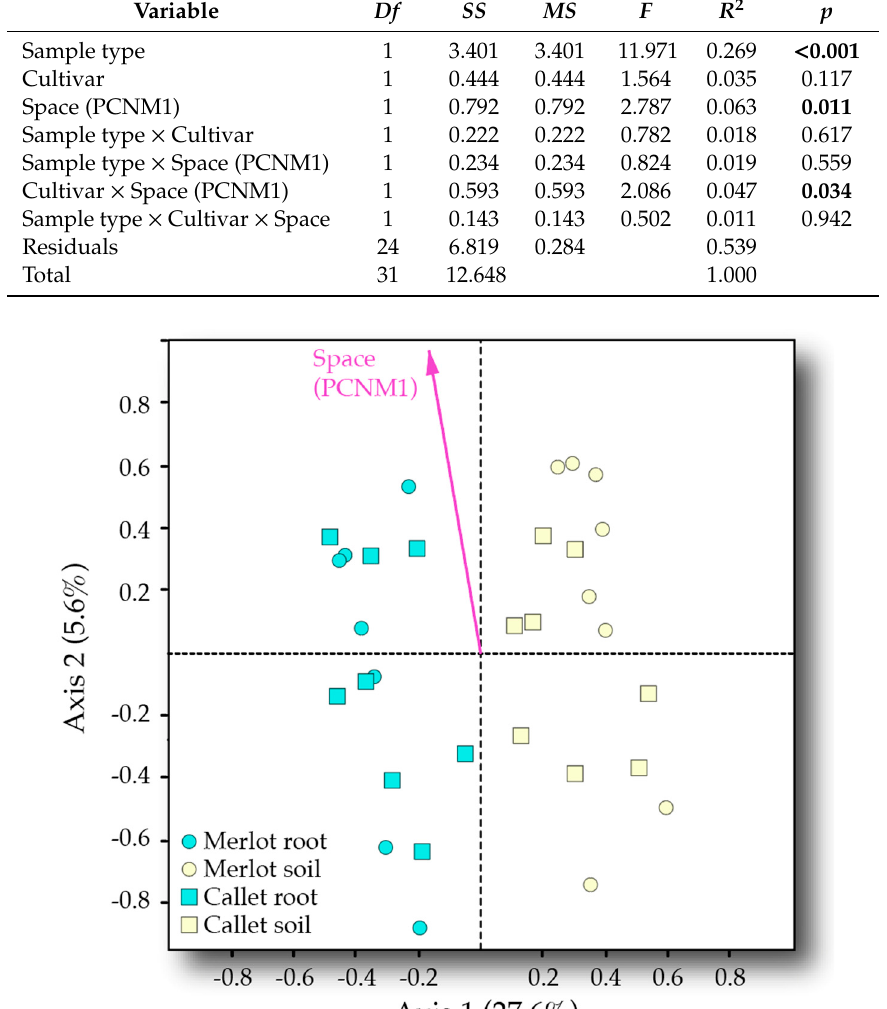
Table 3. Separate PERMANOVAs for cultivar ( a ) or PCNM1 values above and below the median value ( b ); 999 permutations and Euclidean distance as measure of dissimilarity. Bold values indicate significance.